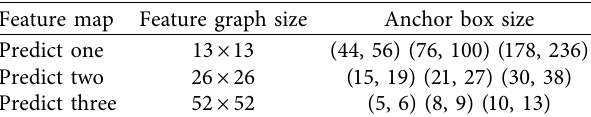
Figure 1: The overall structure of the improved YOLOv4 model integrating lightweight network and dual attention mechanism. Table 1: Characteristic graph and its prior box size